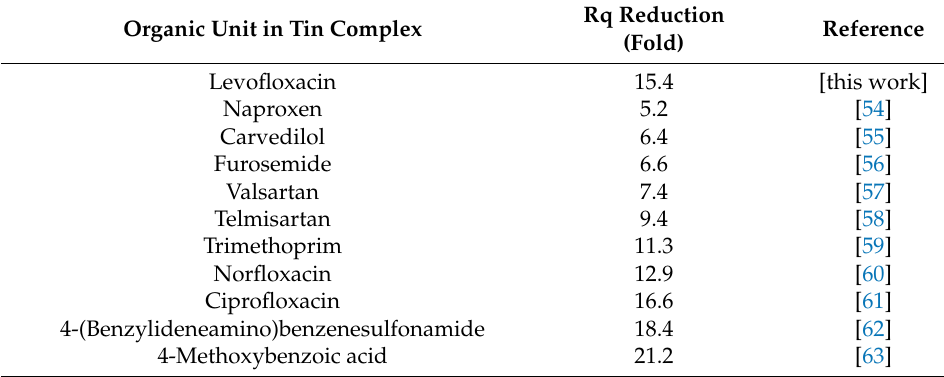
Figure 10. AFM images of blank PVC film: ( a ): before irradiation and ( b ): after irradiation. Table 4. Reduction in the Rq (by fold) of PVC using organotin